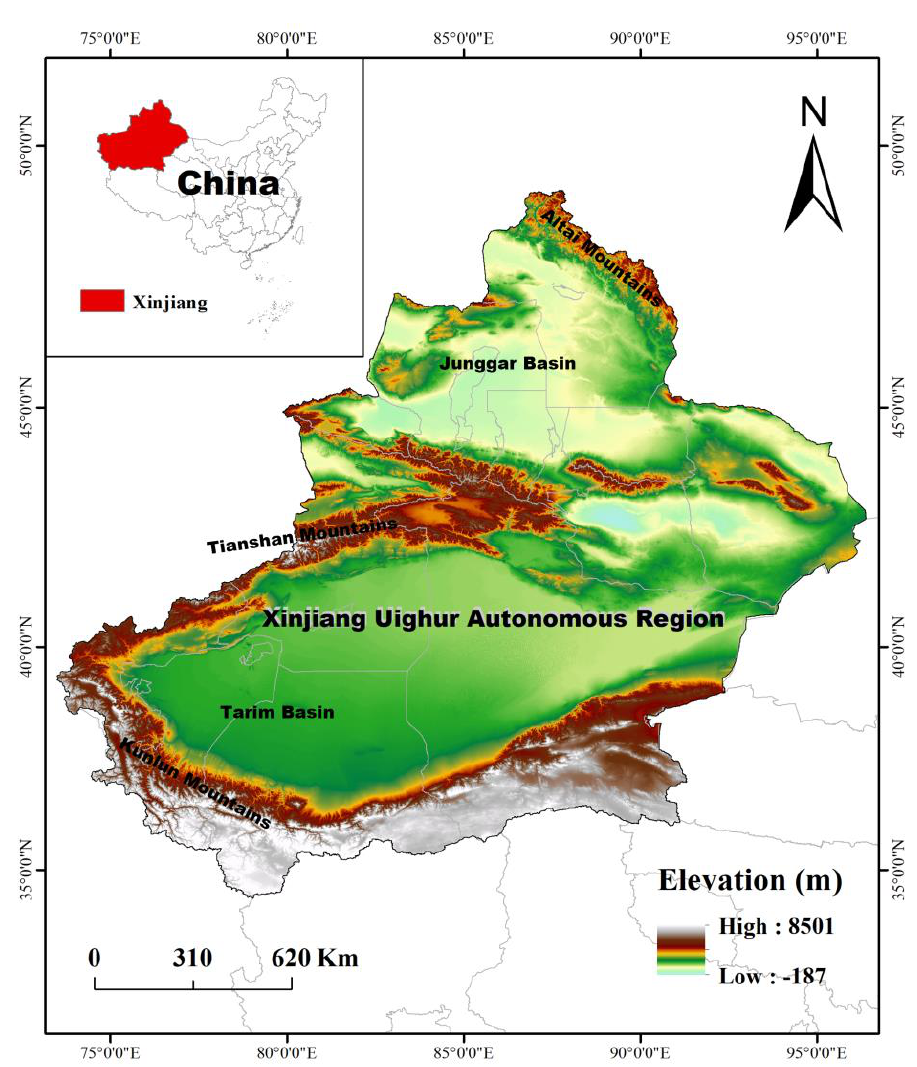
Figure 1. Elevation and Geographic Location of Xinjiang Uygur Autonomous Region in China.